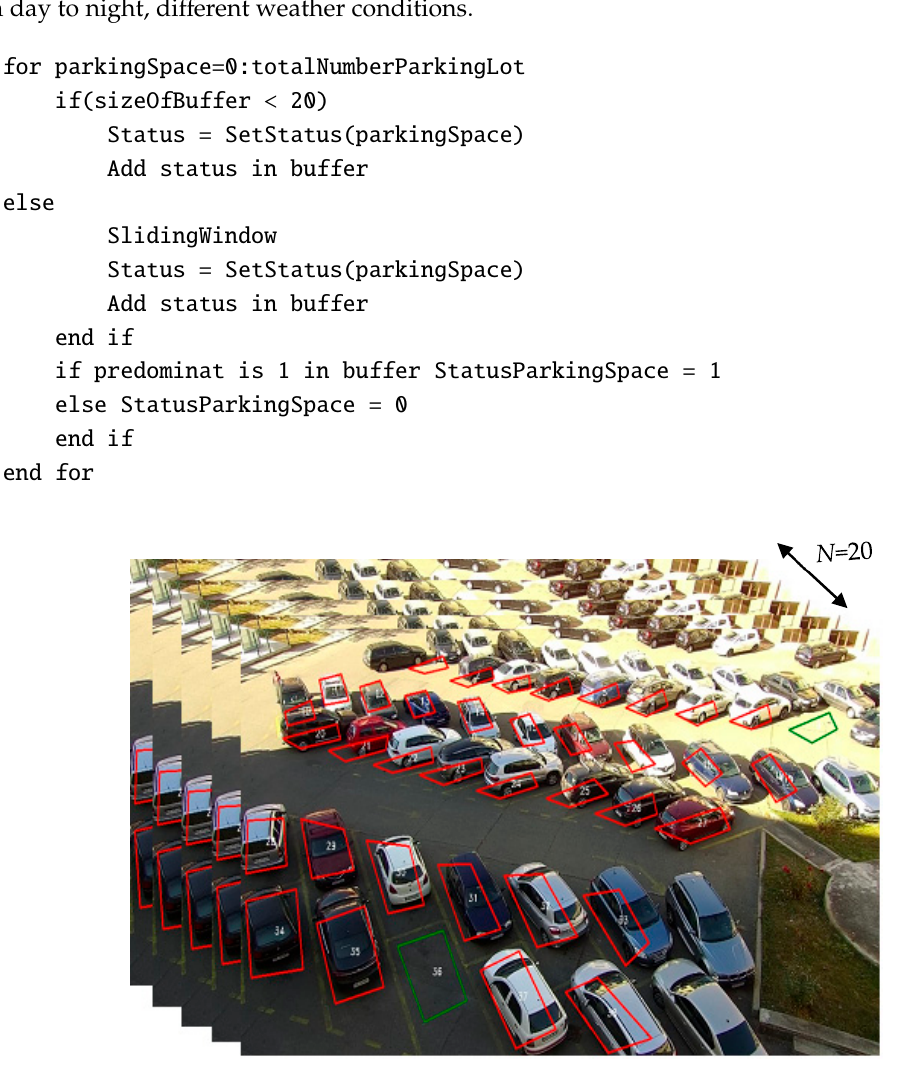
Figure 8. Frame history on 20 consecutive frames.